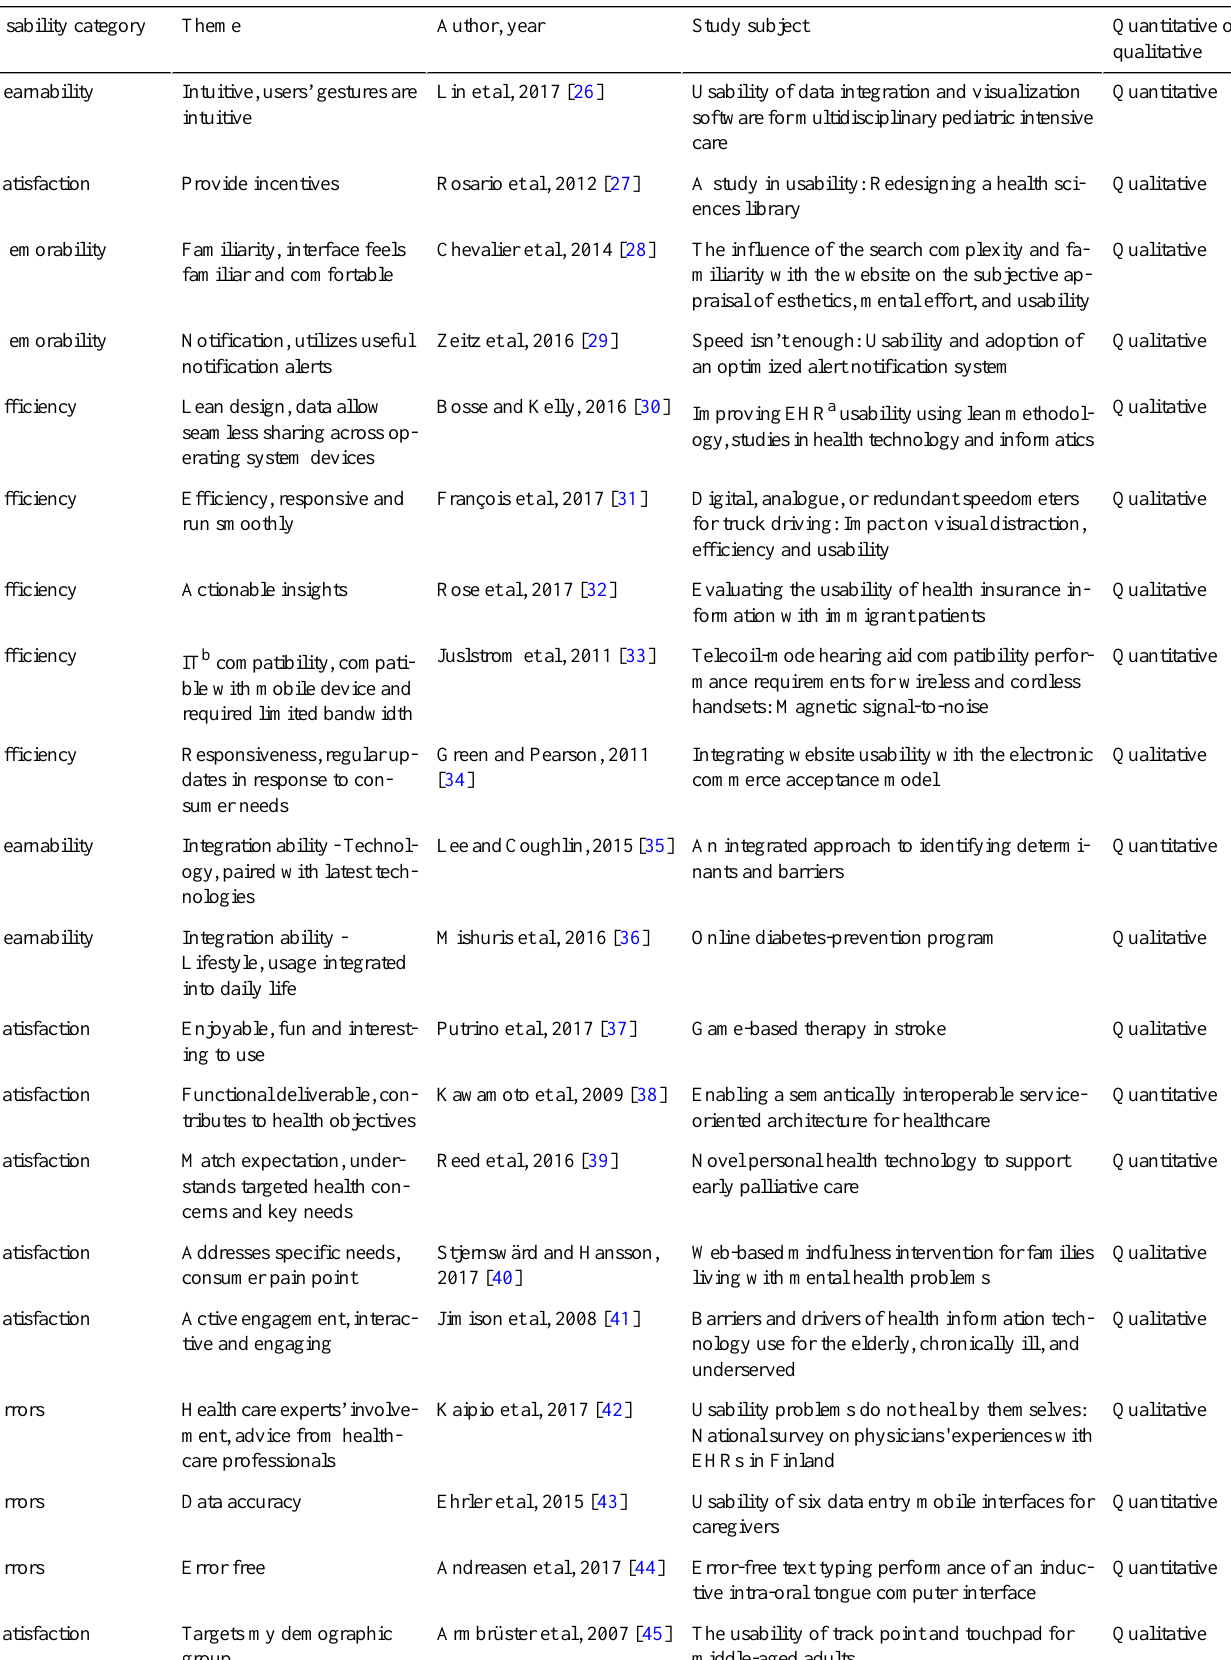
Table 1. Usability themes. Some studies cover multiple themes. For simplicity, only the representative study is stated for each theme.